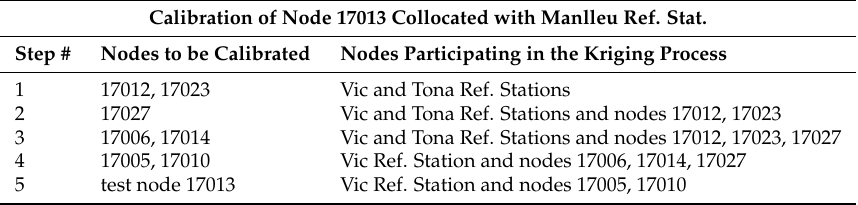
Table 5. Multi-scale calibration with Kriging estimates (Captor node 17013).